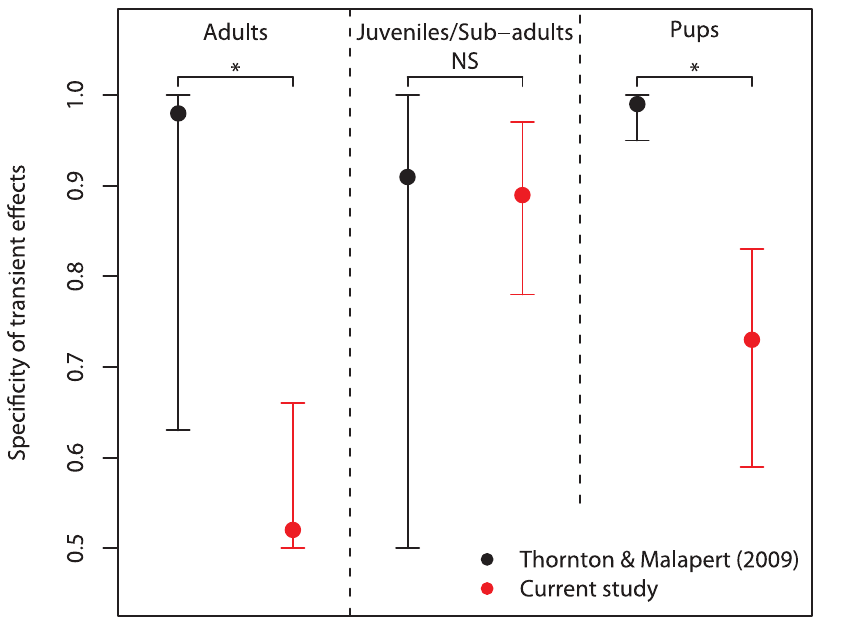
Figure 5. Specificity of the transient social effect for different age classes for the current study and the previous experiment by Thornton and Malapert [ 21 ] . Specificity quantifies the probability a naive observer will use the same option-type it has observed, given that it manipulates one of them immediately after observation. The mean of the posterior sample is shown in each case, with the 95% central interval. * Indicates that the 95% central interval for the difference between the two studies did not include zero, whereas NS signifies that it did.